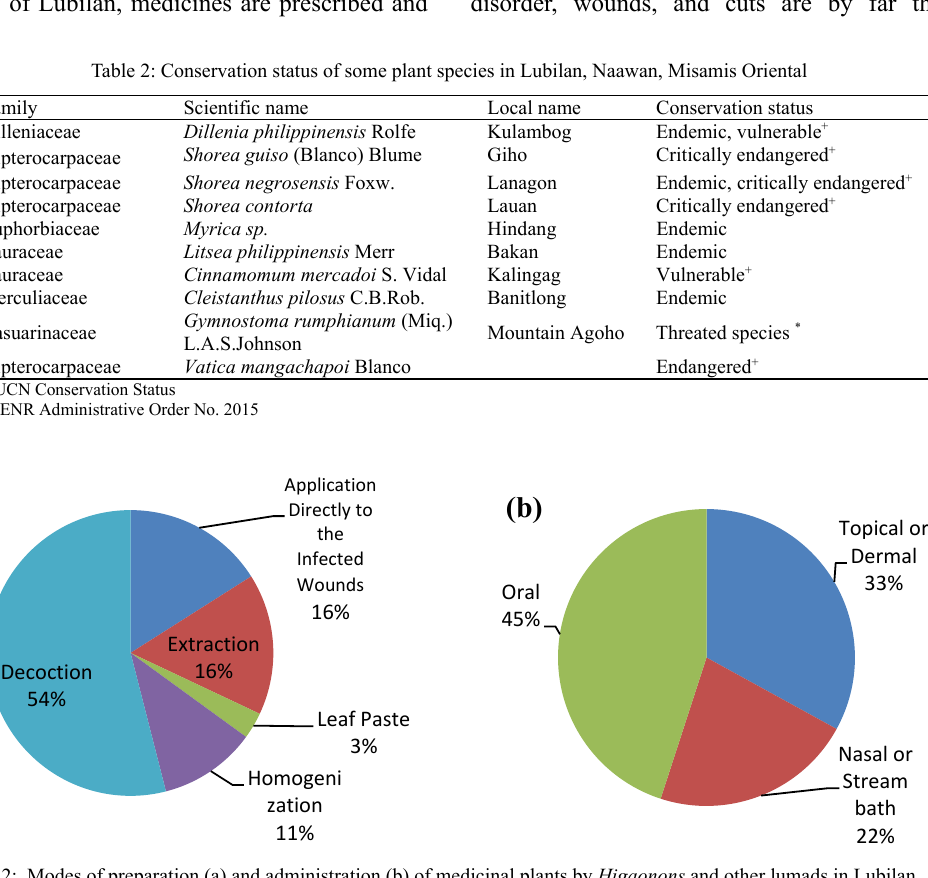
Fig. 2: Modes of preparation (a) and administration (b) of medicinal plants by Higaonons and other lumads in Lubilan, Naawan, Misamis